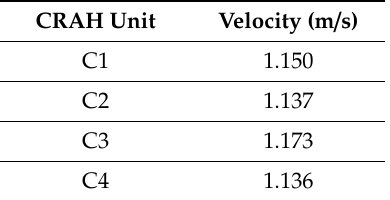
Table 1. Inlet velocity from the CRAH units for the hard floor setup at a supply temperature of 18.3 °C.